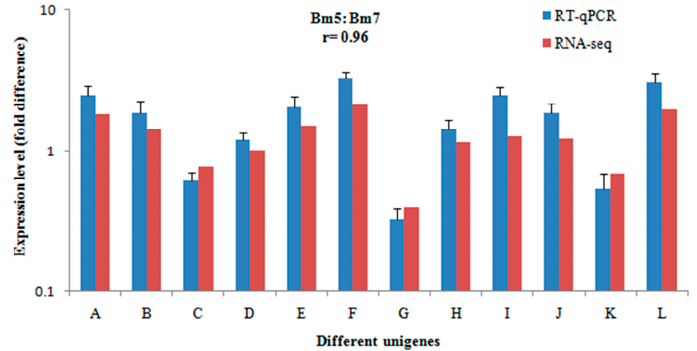
Figure 1. Validation of RNA-Seq data using real-time quantitative PCR (qRT-PCR). The correlations of the 12 unigenes were detected using RNA-Seq (red bars) and qRT-PCR (blue bars). The 12 column pairs (A–L) from left to right represent the following unigenes: CL8625.Contig1, CL8429.Contig1, CL5894.Contig1, CL5488.Contig2, CL5080.Contig2, CL4567.Contig1, CL3263.Contig1, CL2270.Contig1, CL2264.Contig1, Unigene2394, Unigene2628, and Unigene7511. Error bars show standard deviations.